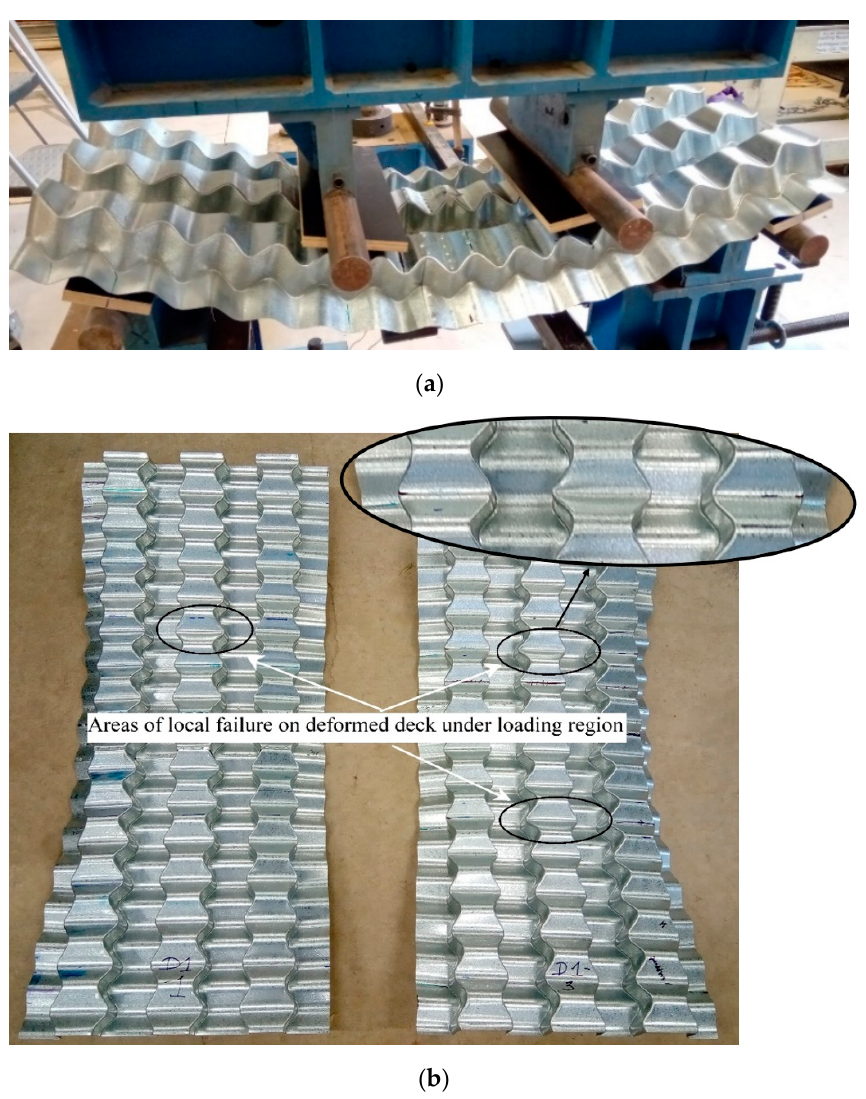
Figure 13. Failure pattern of the tested single-span decks: ( a ) deformed shape of the deck showing